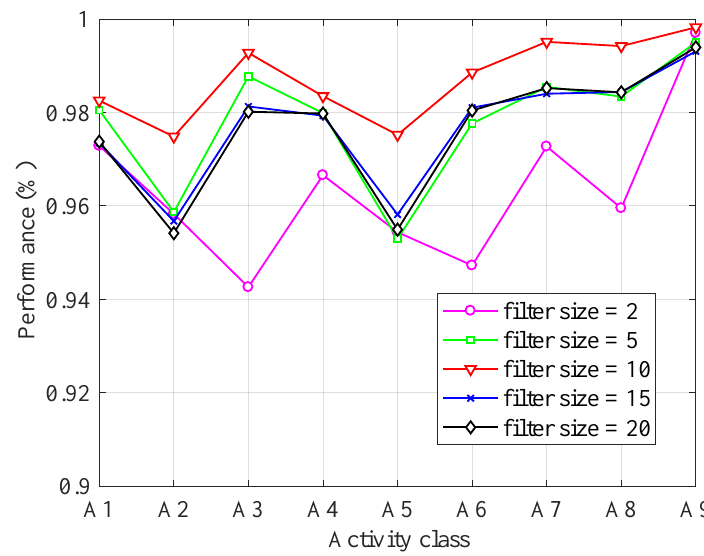
Figure 3. The performance with different filter size.